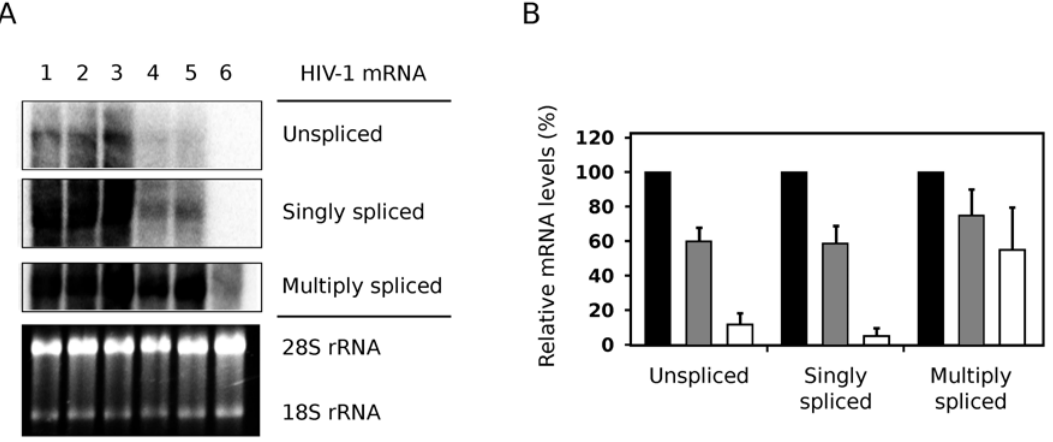
Figure 4. Nullbasic downregulates the levels of unspliced and singly-spliced HIV-1 mRNA expressed in cells. ( A ) Northern blot analysis of total RNA from HEK293T cells expressing pGCH provirus co-transfected with empty vector (pcDNA3.1 + ; ‘‘No Tat’’, lane 1) or co-expressing increasing amounts of Tat-FLAG (lanes 2 and 3; 1:2 and 1:4 molar ratios, respectively) or Nullbasic (lanes 4 and 5; 1:2 and 1:4 molar ratios, respectively). An untransfected control was also included (lane 6). Unspliced, singly-spliced and multiply-spliced HIV-1 mRNA were detected with a single HIV-1- specific probe. 28S and 18S ribosomal RNA (rRNA) species demonstrate equal sample loading. Data are representative of four independent experiments. ( B ) Total RNA was extracted from HEK293T cells expressing pGCH co-transfected with empty vector (black bars) or co-expressing Tat- FLAG (gray bars) or Nullbasic (white bars) before RT-PCR reactions were performed using primers specific to unspliced, singly-spliced and multiply- spliced viral mRNA. Tat-FLAG and Nullbasic plasmids were transfected at 2:1 molar ratios with respect to pGCH. The means and standard deviations of duplicate assays in three independent experiments are shown, with values for each mRNA class expressed as a percentage of the pGCH alone sample.